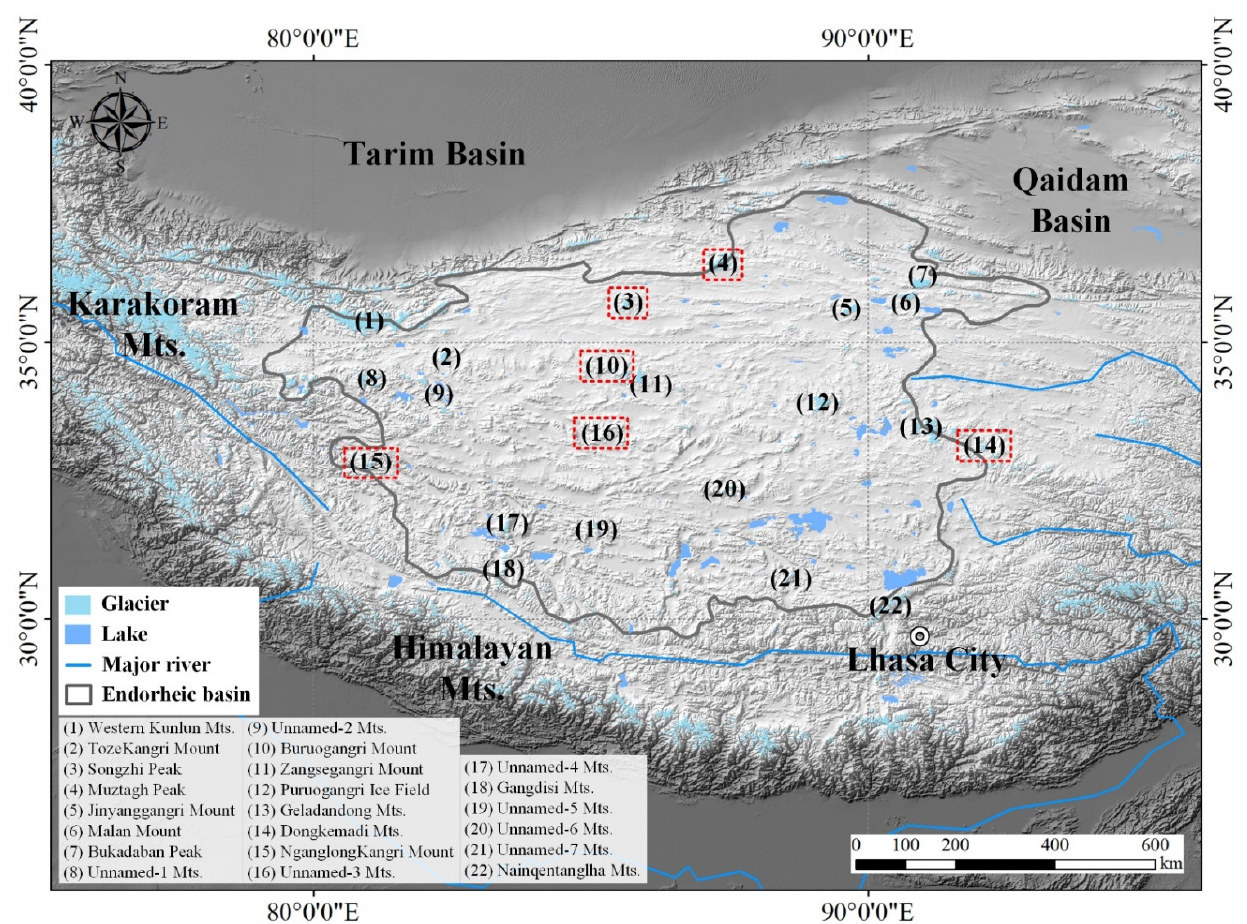
Figure 1. Geographic locations of the 22 study areas over the INTP. The six study sites completely covered by the SRTM-X DEM are labeled by red dashed rectangles. The mountain glaciers are shown in light blue. Gray solid line indicates the boundary of the endorheic basin.